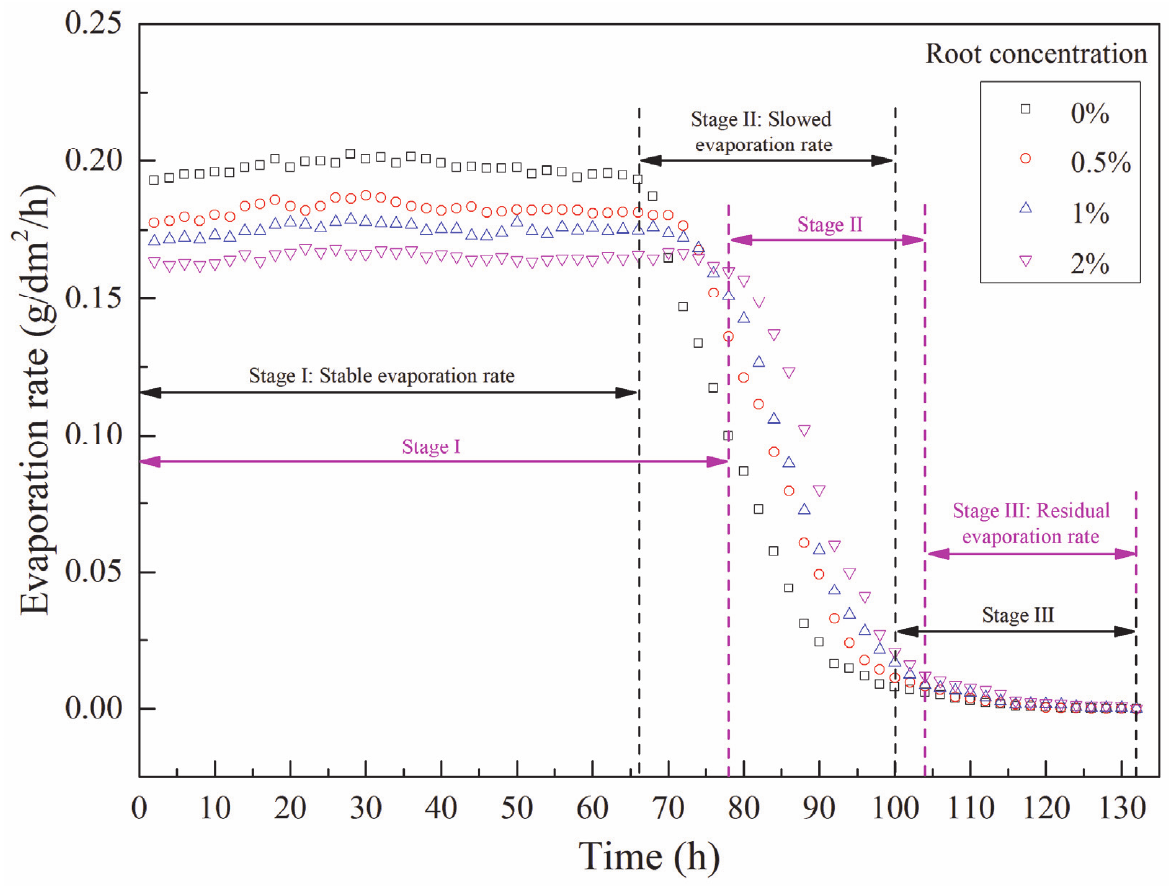
Figure 4. The relationship between evaporation rates and time of saline − alkali soil samples. After binarizing the cracking pictures of Saline-Alkali soil samples, the fractal dimen- sions of the crack surfaces were calculated using the box counting method. Table 2 shows the fractal dimensions of Saline-Alkali soil samples at the beginning and end of cracking. Table 2. Fractal dimensions of saline − alkali soil samples at the beginning and end of cracking.